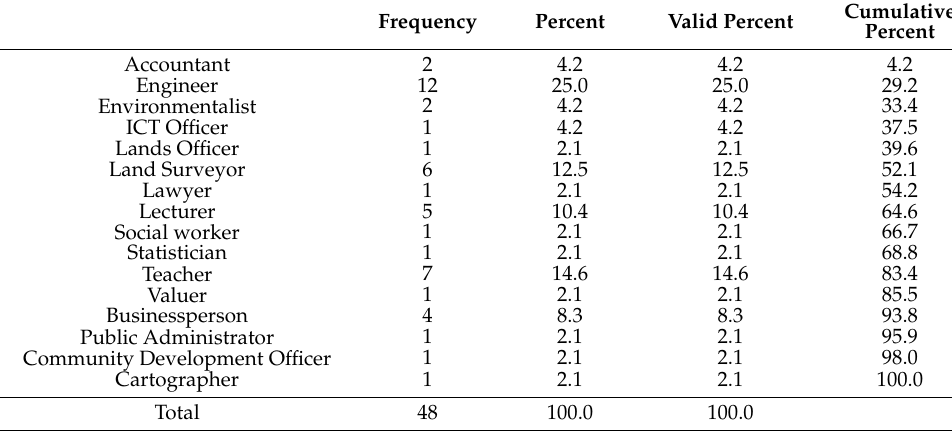
Table A4. Composition of the focused group discussion ( n = 48).